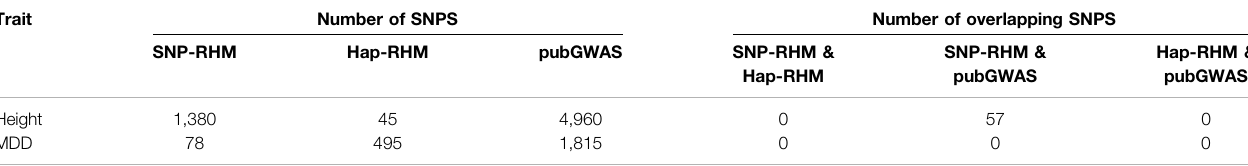
TABLE 2 | Comparison of SNPs within signi fi cant regions identi fi ed by both models and published GWAS results for height and MDD.